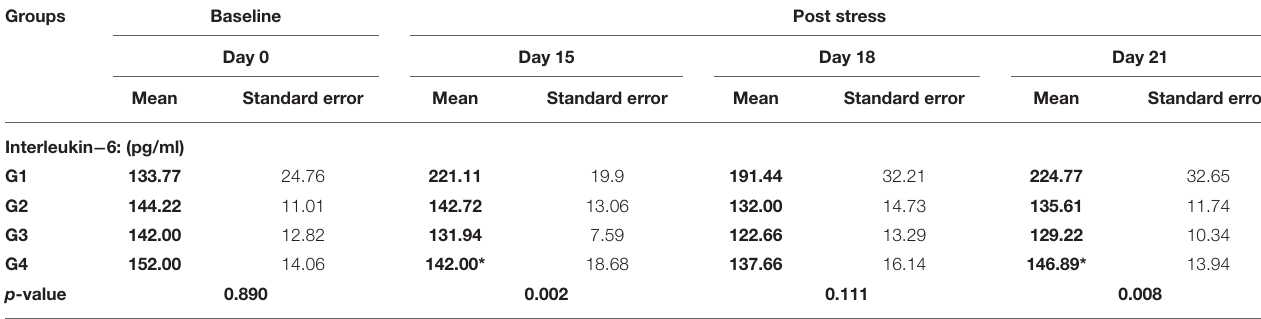
TABLE 1 | Assessment outcome of Interleukin-6 (IL-6) for the four horse groups. Groups